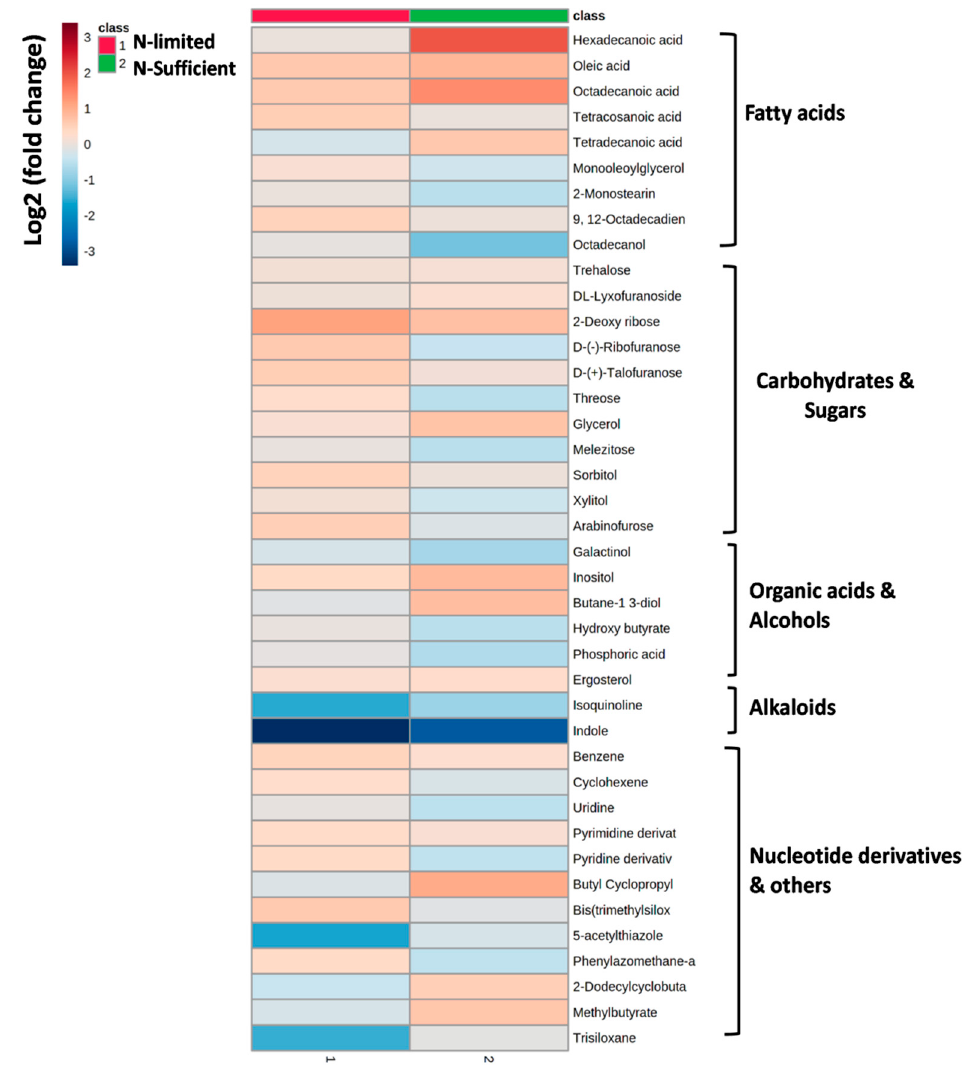
Figure 5. A heatmap depicting metabolites in control [3% glucose, 0.5% (NH 4 ) 2 SO 4 ], N-sufficient [5% glucose, 0.5% (NH 4 ) 2 SO 4 ] and N-limited [5% glucose, 0.12% (NH 4 ) 2 SO 4 ] condition at stationary phase in R. toruloides ( p ≤ 0.05). The color scale represents log2 values with respect to the average value of each metabolite. Colors indicate fold increases (shown in varying degrees of red) or decreases (shown in varying degrees of blue) in concentrations, as indicated in the key.